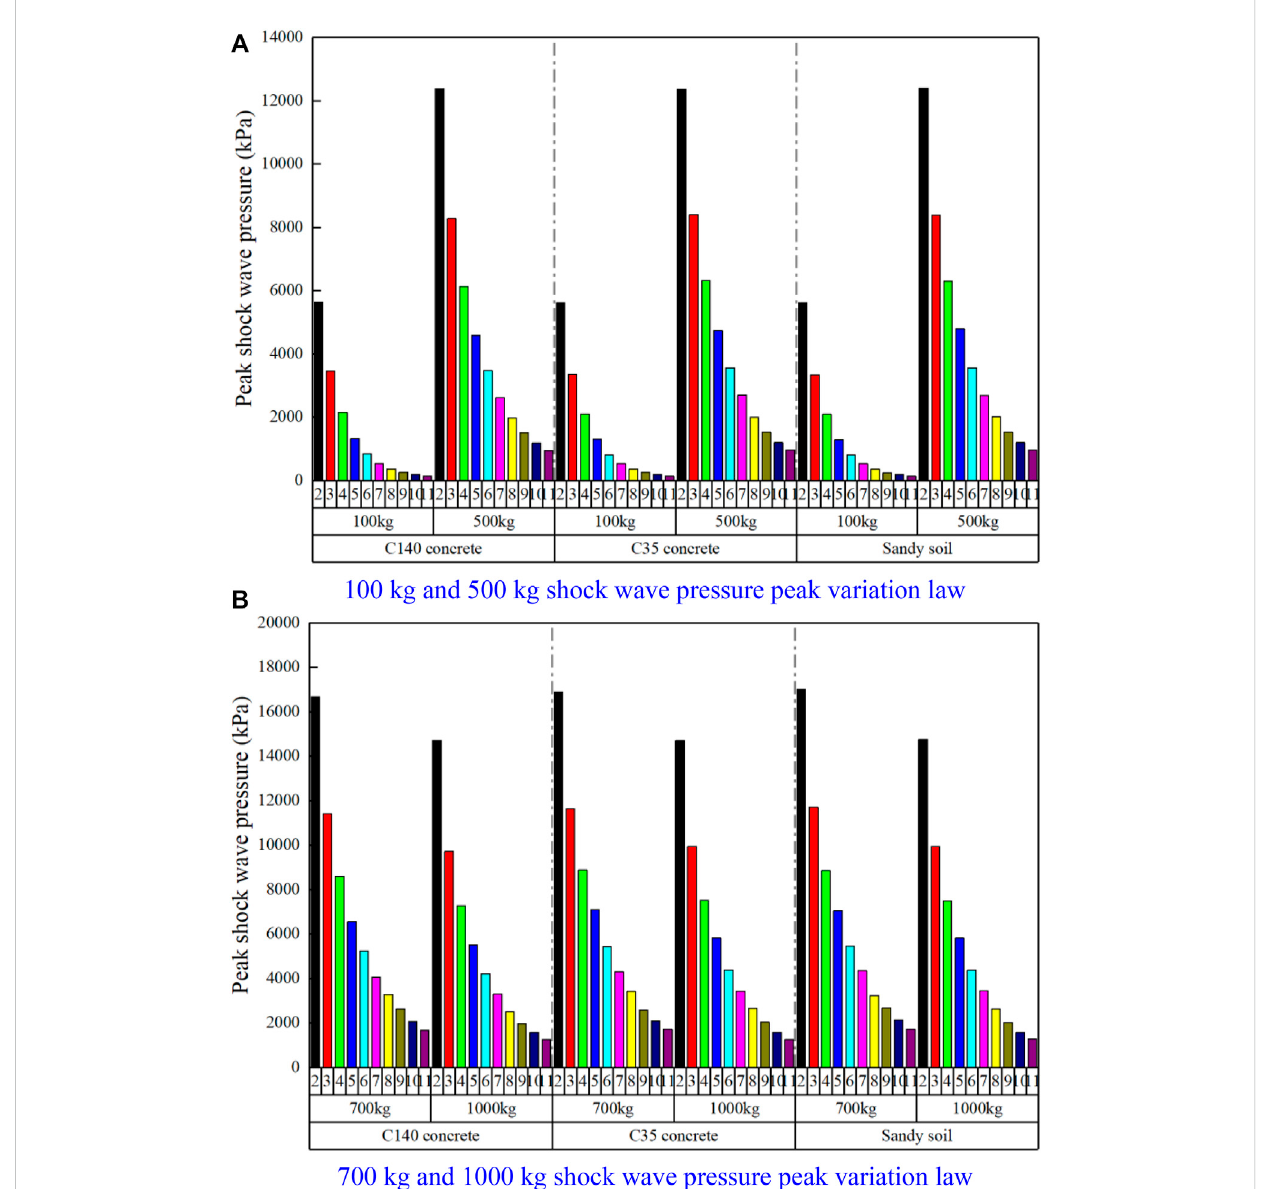
FIGURE 5 Shockwavepressurepeakvaluechangelaw. (A) 100 and500 kgshockwavepressurepeakvariation law. (B) 700and 1,000 kgshock wavepressure peak variation